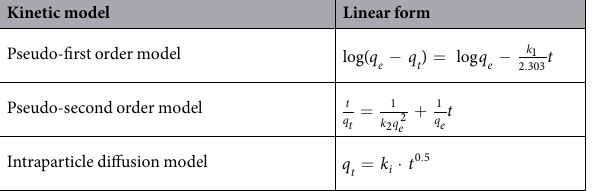
Table 1. Linear forms of pseudo-first order, pseudo-second order and intraparticle diffusion models. k 1 , k 2 , and k i are the rate constant of corresponding kinetics model; q e is the amount of adsorbed copper(II) at equilibrium and q